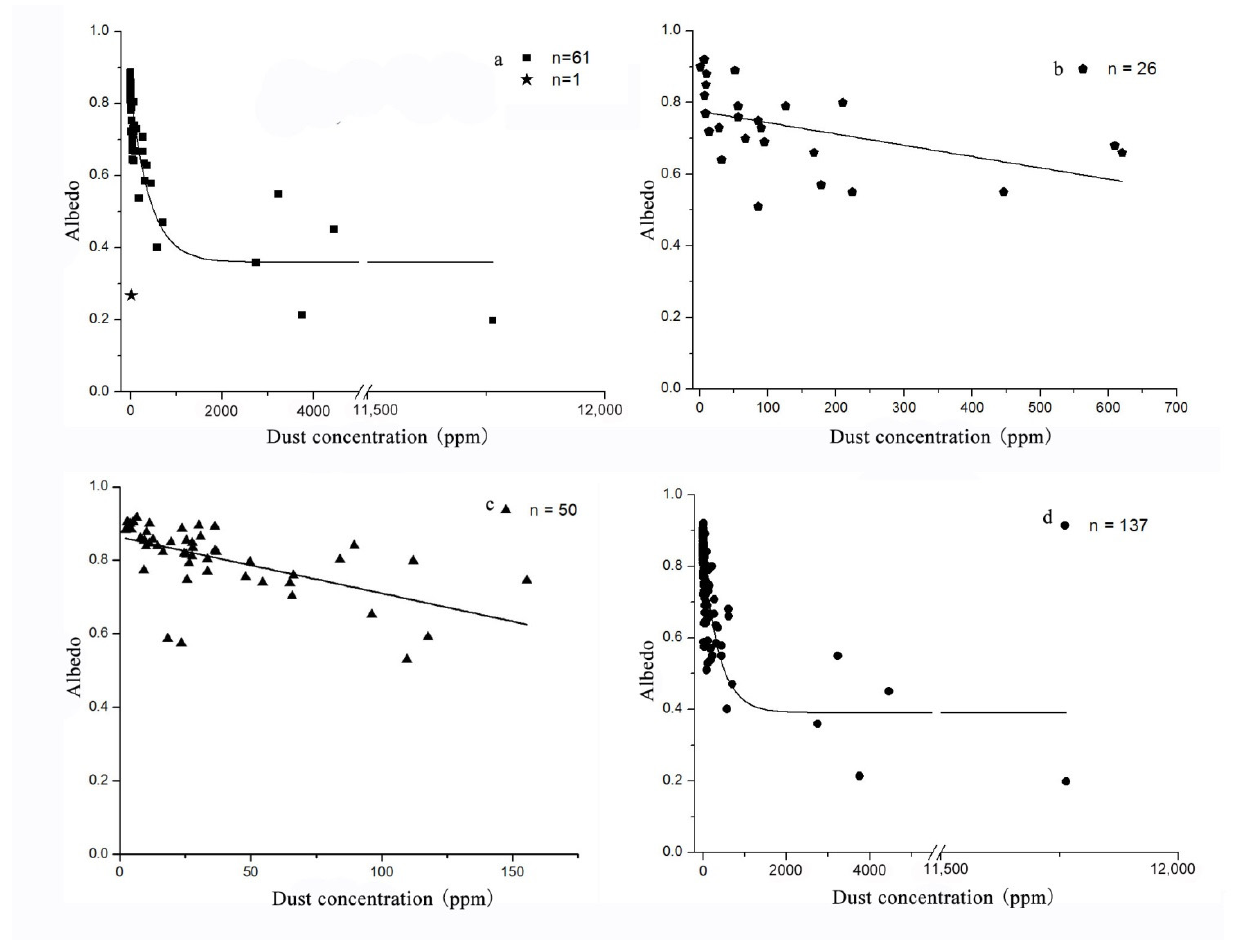
Figure 5. Relationship between dust concentrations and the albedo of surface snow over the QT No. 1 Glacier. Observations are shown for ( a ) 2013, ( b ) 2014, ( c ) 2015, and ( d ) all three years. Combined observations made during the three-year ablation period (Figure 5d) are generally consistent with the individual results collected in 2013, showing that a dust concentration below 1000 ppm has a significant impact on snow’s albedo.